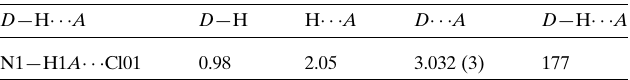
Table 1 Hydrogen-bond geometry (A˚ , (cid:4) ).